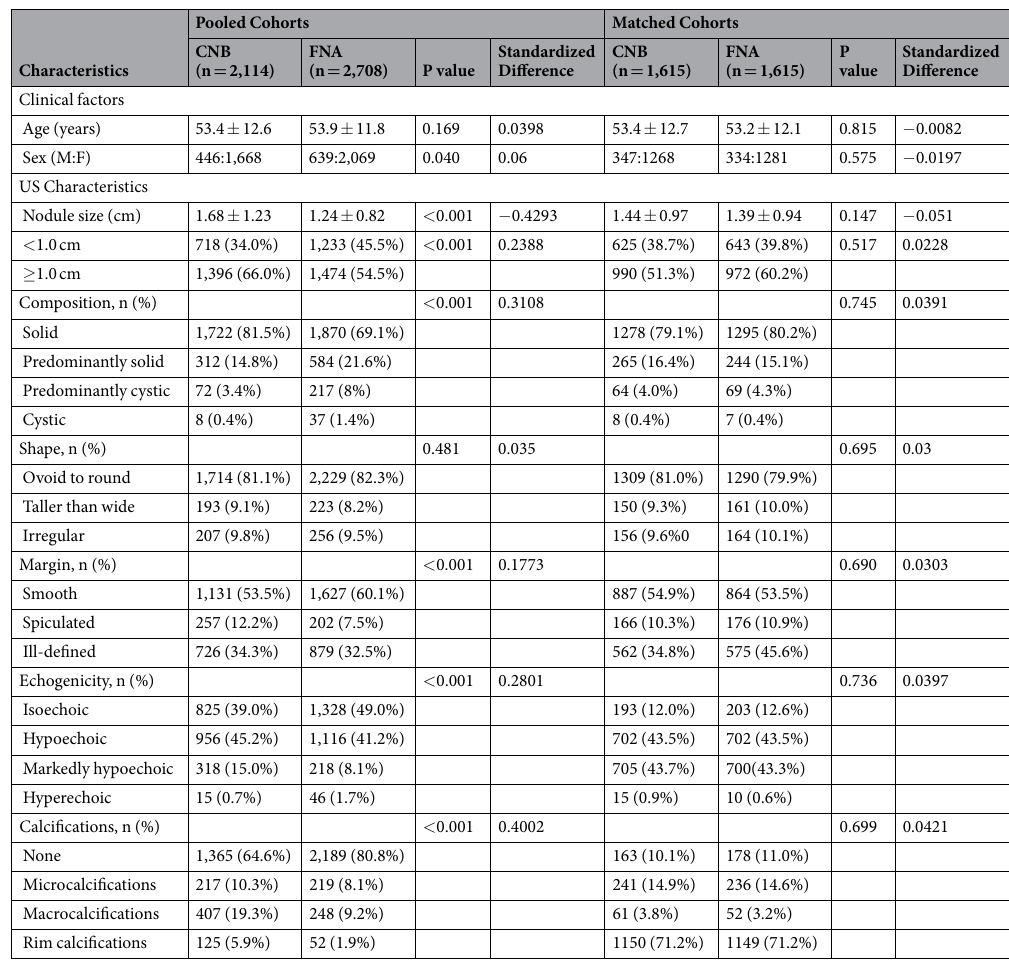
Table 1. Baseline Characteristics of the Pooled and Matched